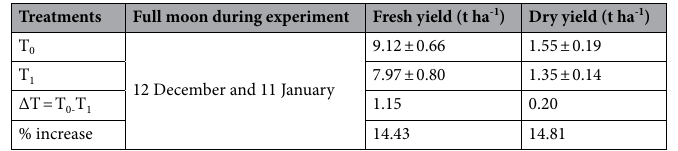
Table 3. Effect of lunar cycle on the yield performance of Gracilaria tenuistipitata.